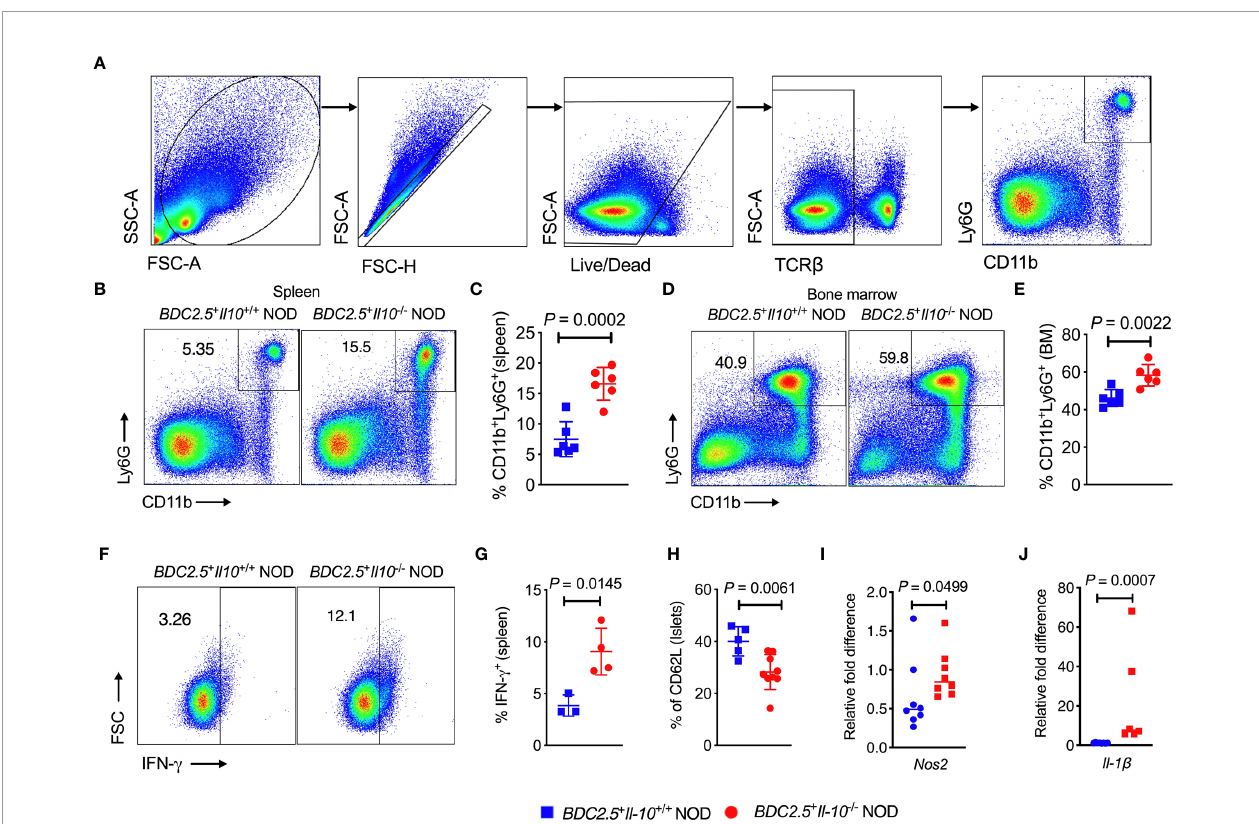
FIGURE 2 | Altered neutrophil homeostasis in BDC2.5 + Il-10 -/- NOD mice compared with BDC2.5 + Il-10 +/+ NOD mice. (A) Gating strategies of CD11b + Ly6G + neutrophils from the spleen. (B, C) Proportion of CD11b + Ly6G + neutrophils in the spleen ( n = 6/group). Representative fl ow cytometric pro fi les (B) , and summary of CD11b + Ly6G + neutrophils gated from TCR- b - cells (C) . (D, E) Proportion of CD11b + Ly6G + neutrophils in the bone marrow ( n = 6/group). Representative fl ow cytometric pro fi les (D) , and summary of CD11b + Ly6G + neutrophils gated from TCR b - cells (E) . (F, G) IFN- g expression in splenic CD11b + Ly6G + neutrophils ( n = 3-4/ group). Representative fl ow cytometric pro fi les (F) , and summary of IFN- g expression (G) . (H) CD62L expression in pancreatic CD11b + Ly6G + neutrophils ( n = 5-9/ group). (I, J) Gene expression of Nos2 (I) and Il-1 b (J) in splenic neutrophils from BDC2.5 + Il-10 +/+ NOD mice and BDC2.5 + Il-10 -/- NOD mice (n = 6-8/group). Data in (C, E, H – J) were combined from two or more independent experiments. The experiment in (G) was performed twice and consistent results were obtained. Data in (C, E, G, H) are shown as mean ± SD and were analyzed using a two-tailed Student ’ s t -test. Data in (I, J) are presented as median and were analyzed using a two- tailed Mann-Whitney test. P < 0.05 was considered statistically signi fi